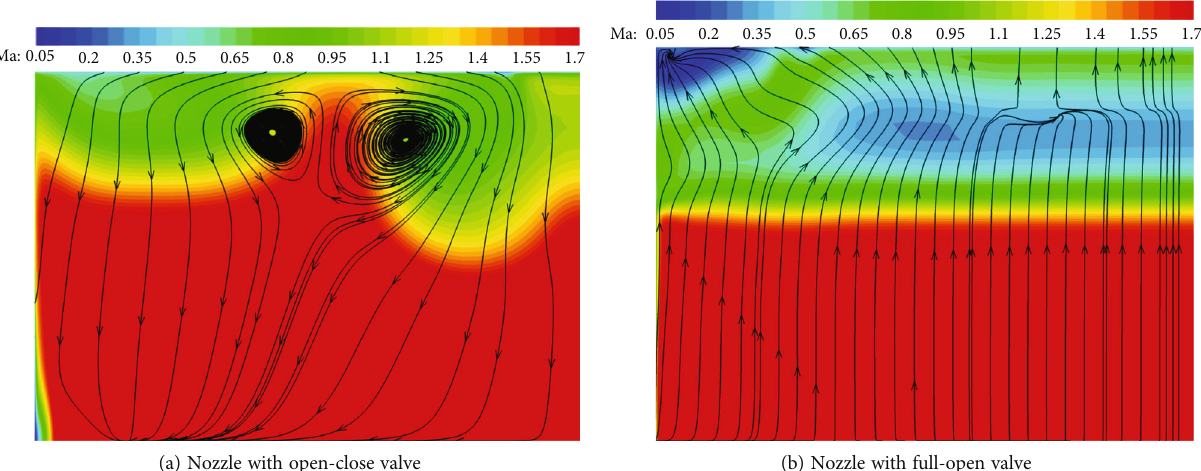
Figure 12: Vortex structure of monitoring surface b (turning point of the tail nozzle).